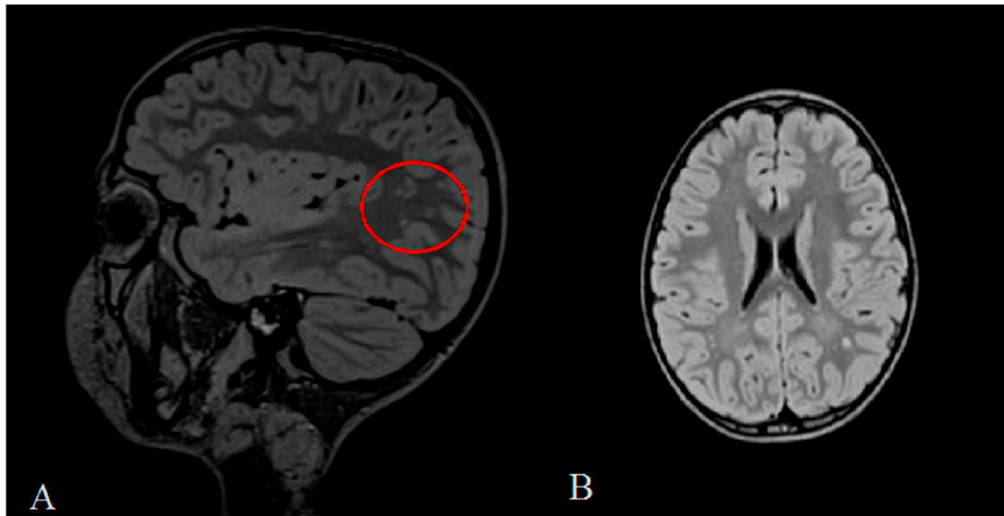
Figure 2. ( A , B ) Brain Nuclear Magnetic Resonance (NMR) Imaging showed millimetric hyperintense areoles of non-specific gliosis in the bilateral white substance, mostly in the occipital region as